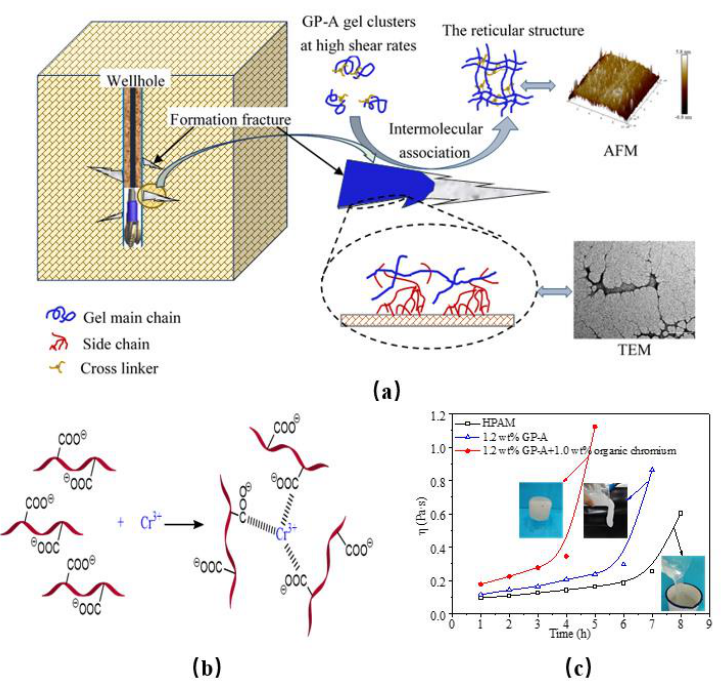
Figure 3. Preparation and mechanism of physically crosslinked GP-A gel as a lost circulation control agent ( a ) Schematic diagram of gel plugging in fracture; ( b ) schematic of the interaction between the GP-A gel and crosslinking agent; ( c ) gelation time of the GP-A gel under the organic chromium crosslinker [33]. (Reprinted/adapted with permission from Ref. [33]. 2021, Wang, et al.). In situ crosslinked polymer gels have the following advantages: (a) in situ crosslinked polymer gels used for formation plugging can generate a high-strength bulk gel in in situ pores and fractures to achieve high-strength plugging; (b) in situ crosslinked polymer gels used for oil-gas profile control and displacement have a continuous phase with suitable accessibility to formation pores and fractures of different sizes; thus, they can displace oil and gas in pores and fractures in a wide range with high sweep and displacement efficiencies; (c) in situ crosslinked polymer gels have a simple preparation and injection process but still have the following problems: (i) during the injection process, the polymer gel solution will be affected by the shearing effect of the pores in the formation, and the macromolecular chains break easily, leading to a significant reduction in the solution viscosity, which affects gelation; (ii) due to multiple components, the gel solution will exhibit chromatographic separation between the components and formation water